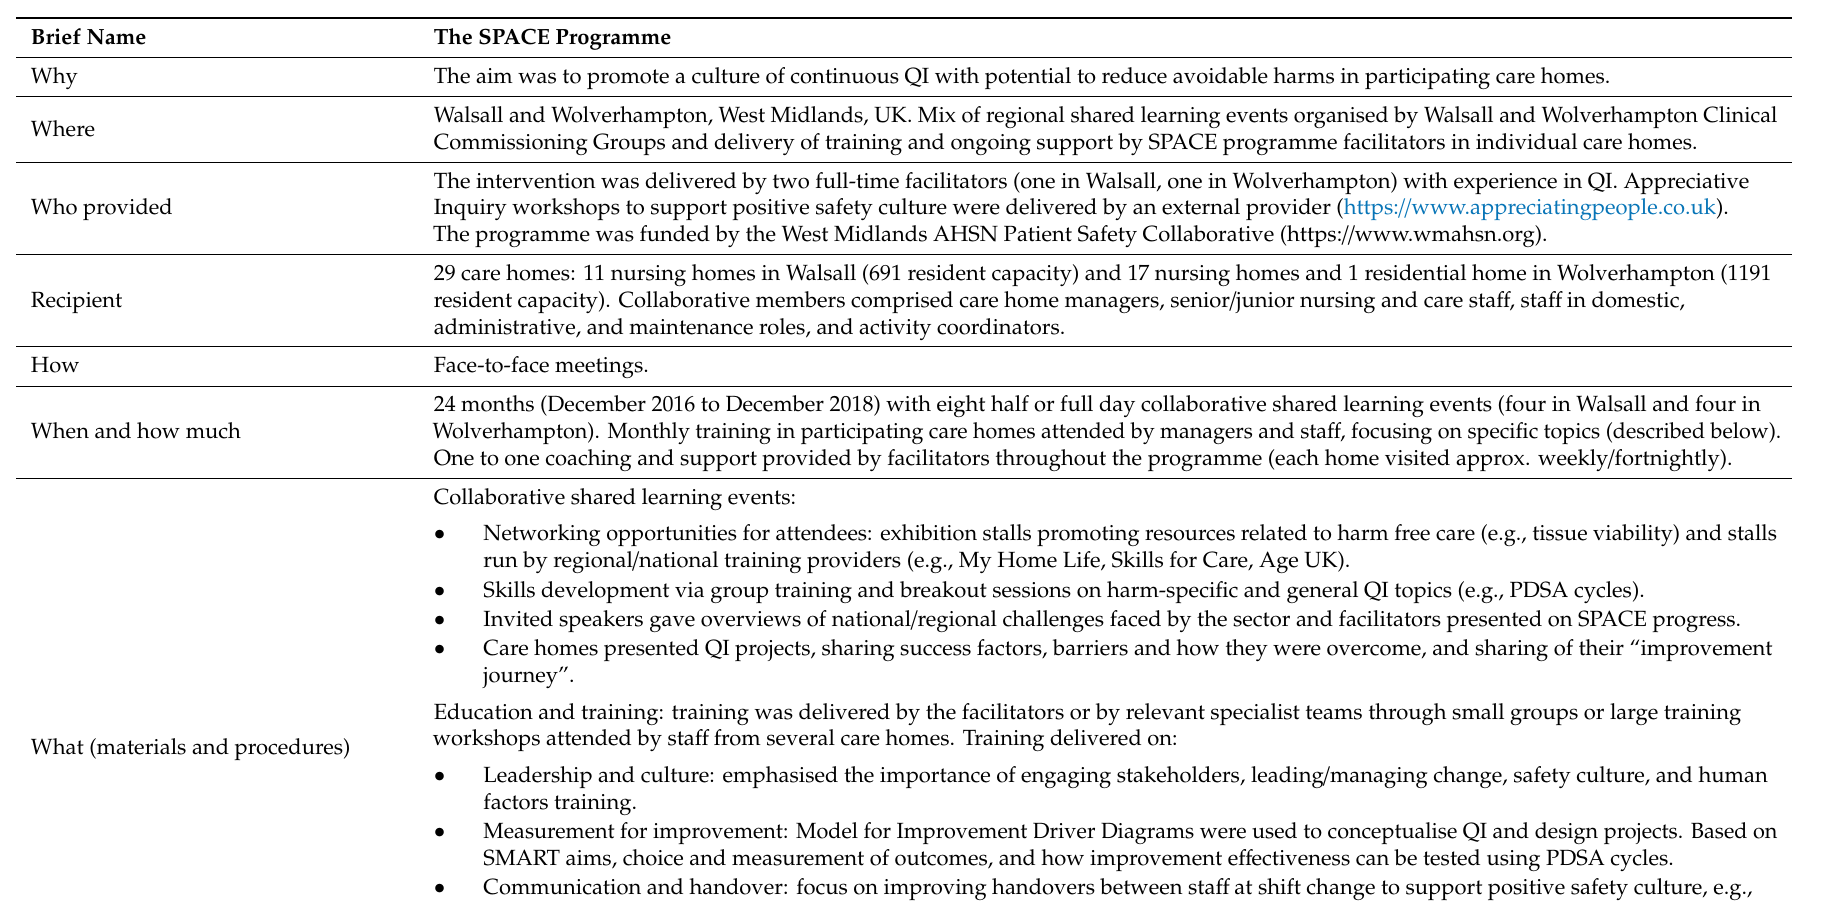
Table 4. Description of the SPACE Quality Improvement